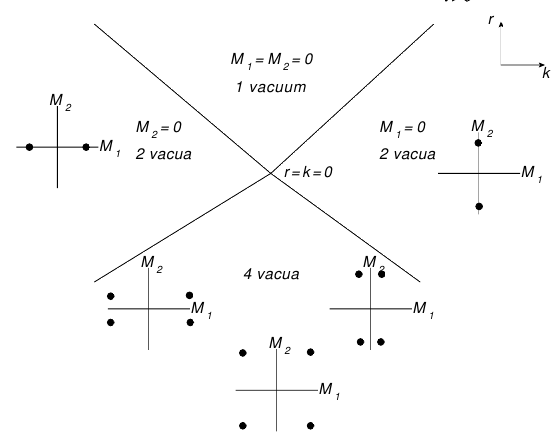
Figure 6 . The phase diagram of the potential (6.1) for ν < 0.